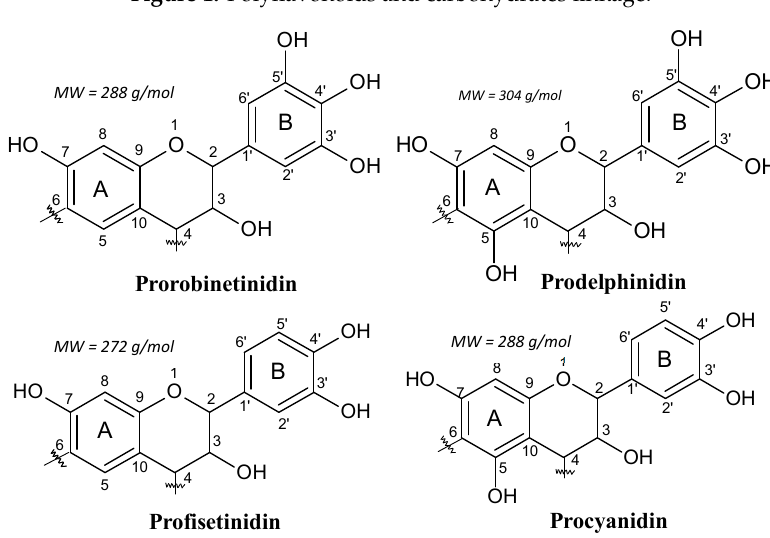
Figure 2. The four repeating flavonoid units in condensed tannins.